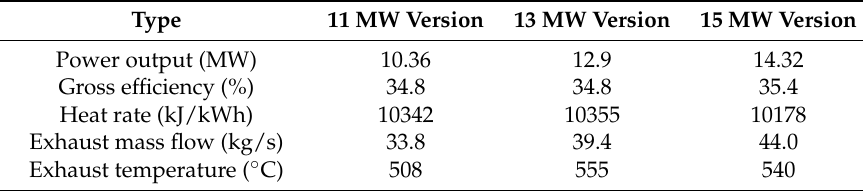
Table A2. The characteristics of 11MW to 15MW gas